Question: What caption would you write for this figure?
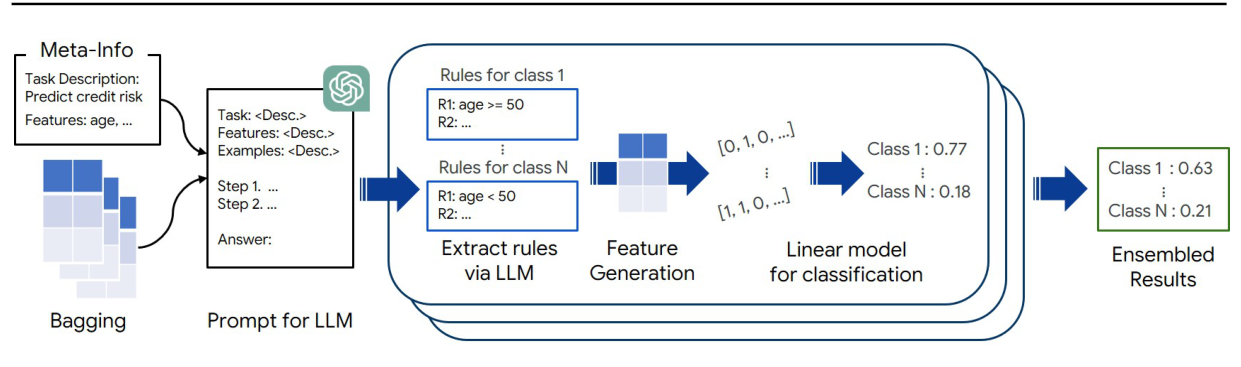
Answer: Illustration of FeatLLM. FeatLLM extracts rules for each class, utilizing prior knowledge and few-shot examples. These rules are then parsed and applied to create binary features for data samples. A linear layer is trained on these binary features to estimate class likelihoods. This procedure is repeated multiple times for ensembling.